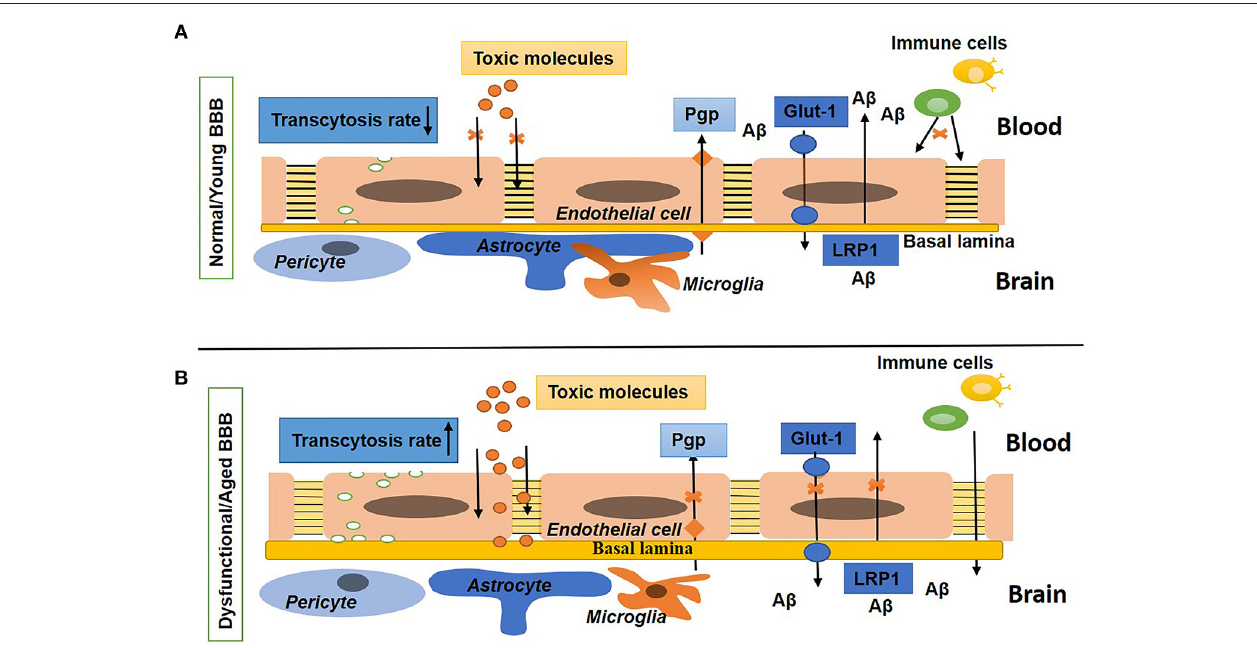
FIGURE 1 | Schematic diagram shows the normal/young blood–brain barrier (BBB) and dysfunctional/aged BBB. (A) Shows BBB in a young or normal state with tight and adherens junctions, a low rate of transcytosis, no diffusion of toxins, the presence of influx (Glut-1) and efflux (P-gp) transporters, and a low expression of leukocytes adhesion molecules (LAMs). The basal lamina is thin and surrounded by pericytes, astrocyte endfeet, and microglia. (B) Shows BBB in an aged or disease state with a high rate of transcytosis and diffusion of toxins, repression in influx and efflux transporters, upregulated expression of LAMs, and increased density of the extracellular matrix (ECM). Pericytes, astrocytes, and microglia are not associated with the basal